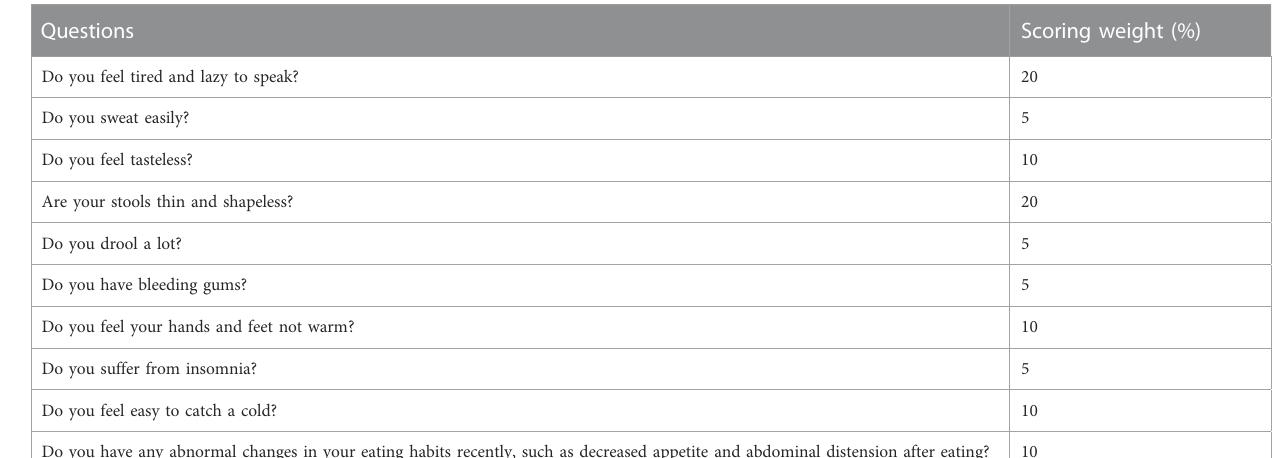
TABLE 1 Spleen de fi ciency rating